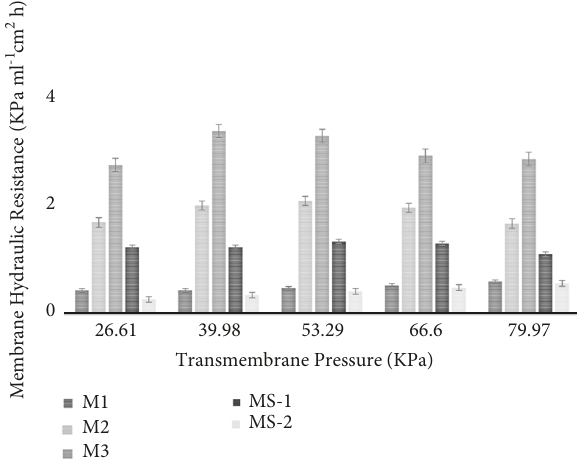
Figure 7: Membrane hydraulic resistance of prepared membranes measured at different